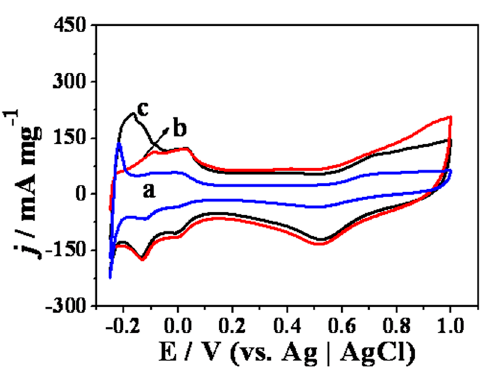
Figure 6. Cyclic voltammograms (CVs) of Pt/C ‐ JM (a), Pt/GNs (b) and Pt ‐ Ag/GNs (c) in 0.5 M H 2 SO 4 ; scan rate: 100 mV ∙ s − 1 .